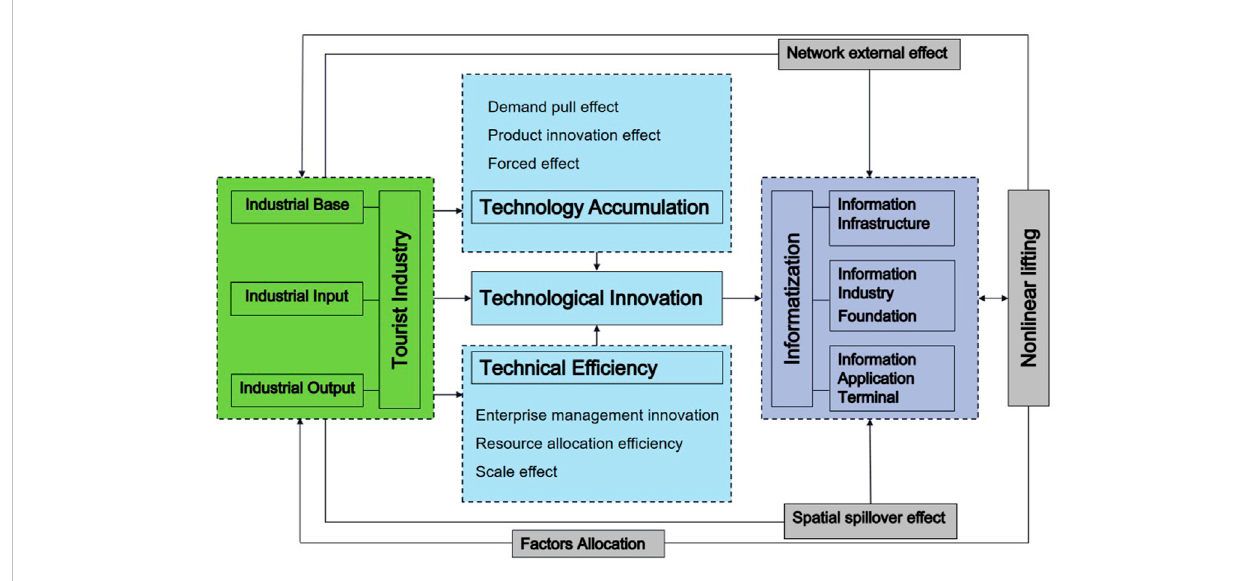
FIGURE 1 In fl uencing mechanism framework of tourism industry, technological innovation, and